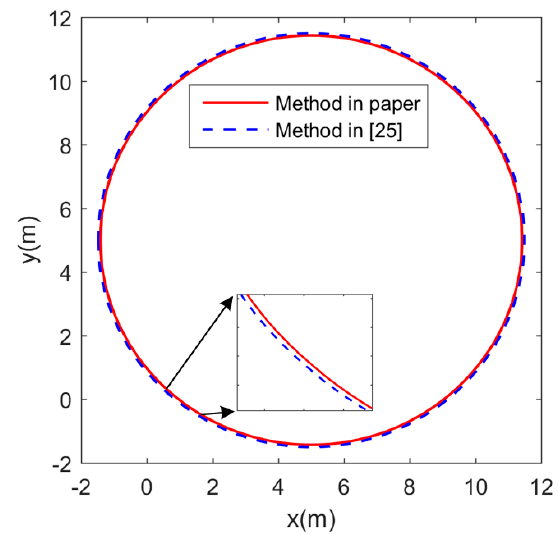
Figure 11. The simulation results of a circle test of the two identification methods.